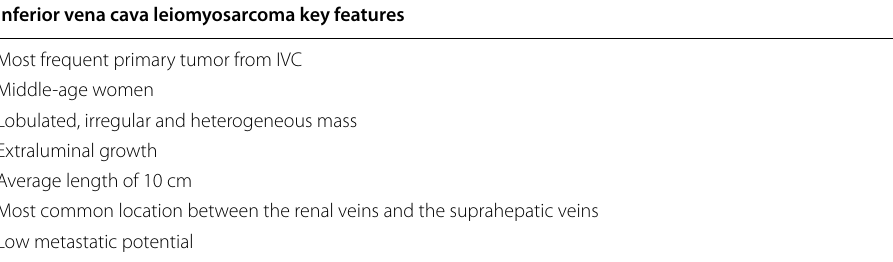
Table 1 Inferior vena cava leiomyosarcoma key features Inferior vena cava leiomyosarcoma key features Most frequent primary tumor from